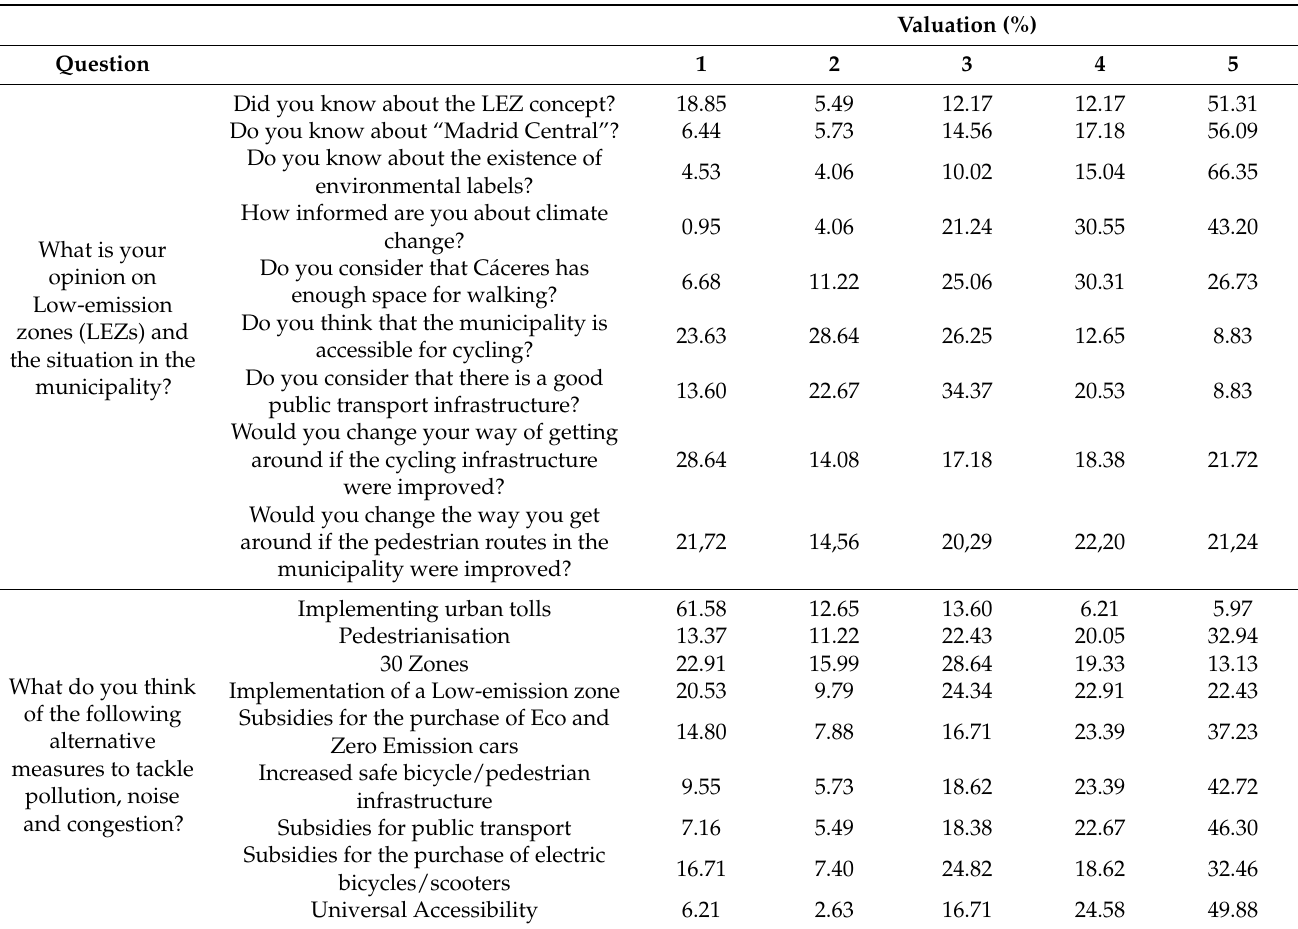
Table 6. Opinion on Low-emission zones (LEZs) and proposed